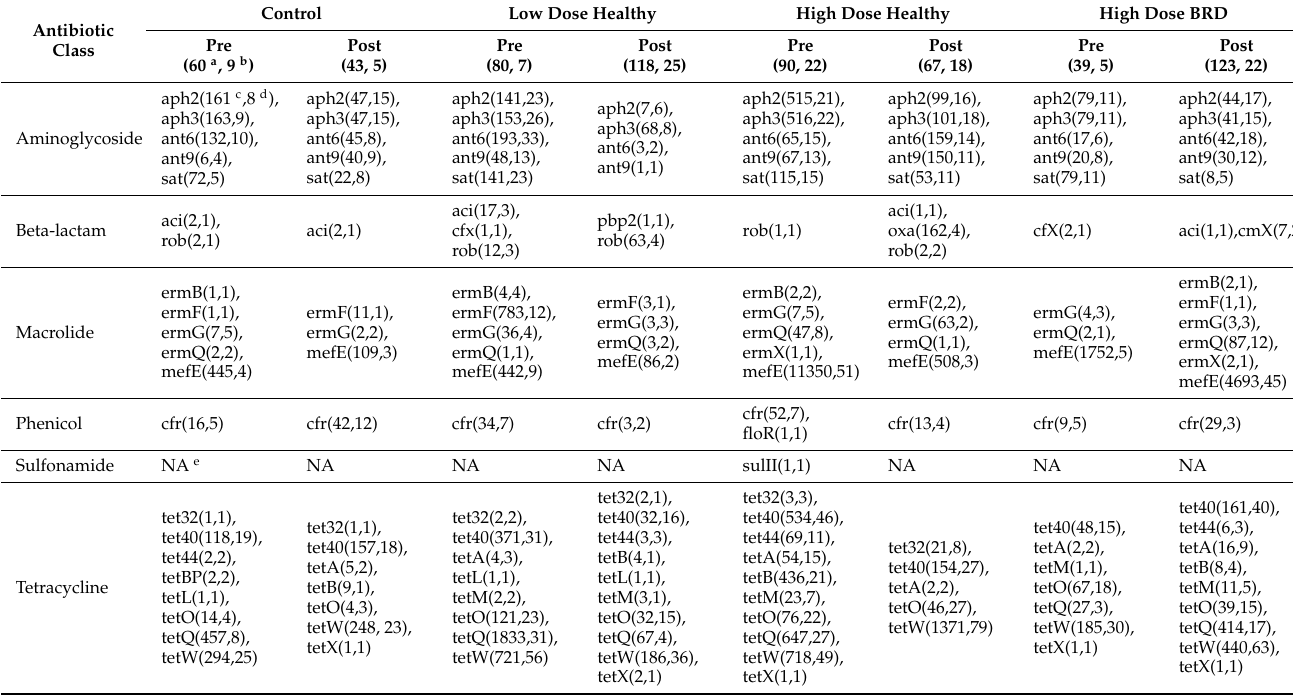
Table 7. Antimicrobial resistance determinants detected in four groups of calves in pre-and post-treatment pooled fecal samples from calves by metagenomic Hi-C.